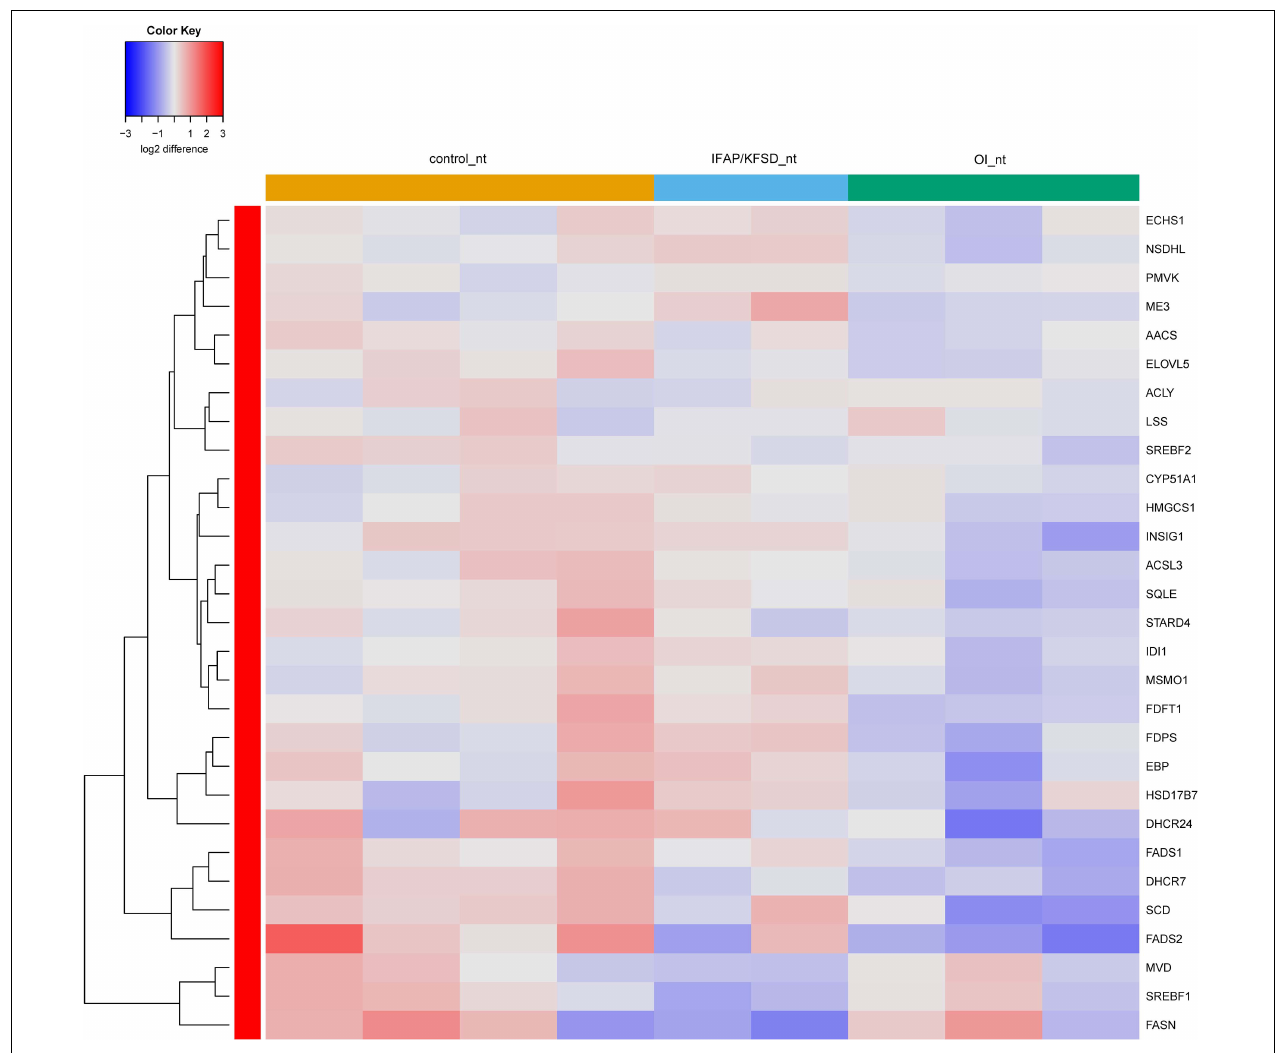
FIGURE 7 | Heatmap depicting expression levels of SREBP-dependent genes at basal conditions. The dendrogram on the left y-axis shows clustering of the